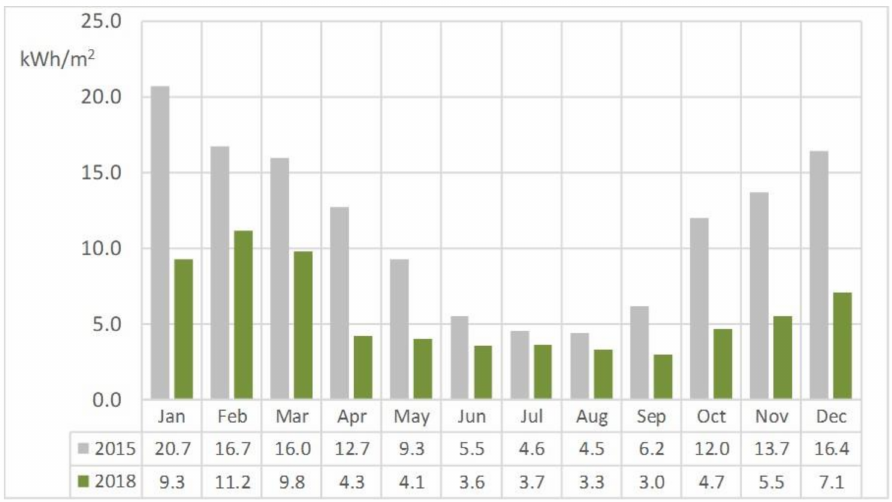
Figure 7. Specific monthly district heating